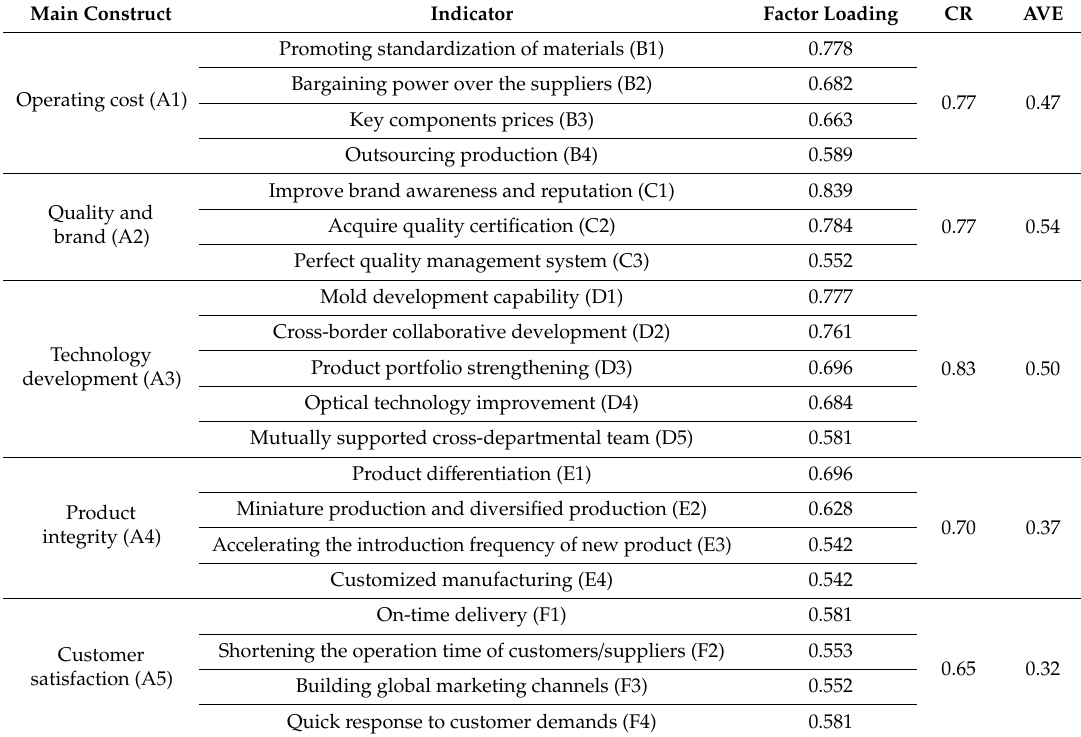
Table 3. The confirmatory factor analysis results of key success